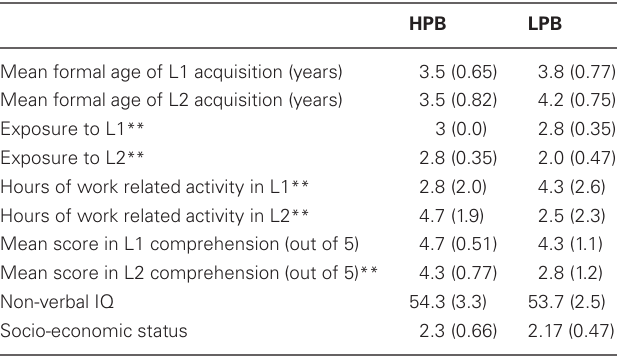
Table 1 | Demographic details and mean non-verbal IQ of high-proficient bilinguals (HPB) and low proficient bilinguals